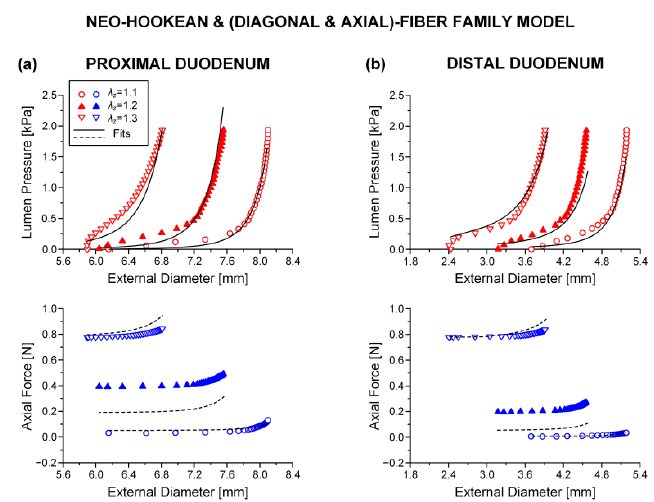
Figure 6. As Figure 2 but using the neo-Hookean and (diagonal and axial)-fiber family model with the following best-fit model parameters for the ( a ) proximal duodenum: 𝜇 = 3.7 × 10 −11 kPa, 𝑘 1𝑑 = 0.312 kPa, 𝑘 2𝑑 = 16.078, 𝑘 1𝑎 = 8.467 kPa, 𝑘 2𝑎 = 3.143, 𝑎 0 = 0.670 rad, ε = 0.321, 𝑅 2 = 0.870, 𝑑𝑒𝑡(𝐑) = 0.018 and ( b ) distal duodenum: 𝜇 = 3.1 × 10 −6 kPa, 𝑘 1𝑑 = 0.707 kPa, 𝑘 2𝑑 = 5.332, 𝑘 1𝑎 = 0.915 kPa, 𝑘 2 𝑎 = 9.892, 𝑎 0 = 0.319 rad, ε = 0.375, 𝑅 2 = 0.838, 𝑑𝑒𝑡(𝐑) = 3.7 × 10 −5 . Data are shown every 0.5 mmHg for clarity.